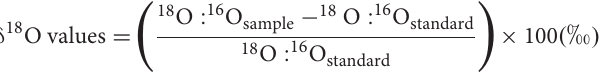
Frontiers in Marine Science |